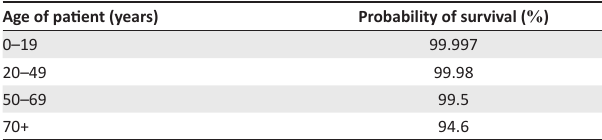
TABLE 4: Survival rates for different ages infected with